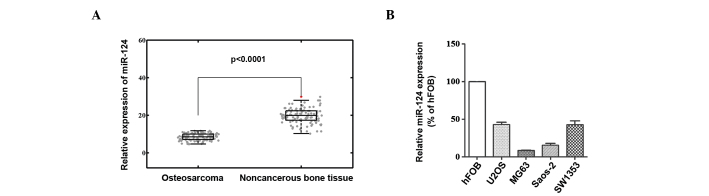
Expression of miR-124 in osteosarcoma tissues and cell lines. (A) miR-124 expression was significantly lower in osteosarcoma tissues than in the corresponding nontumorous samples; (B) miR-124 expression was down-regulated in osteosarcoma cell lines MG63, U2OS, Saos-2, and SW1353, compared to human normal osteoblastic cell line hFOB 1.19. miR-124, microRNA-124.